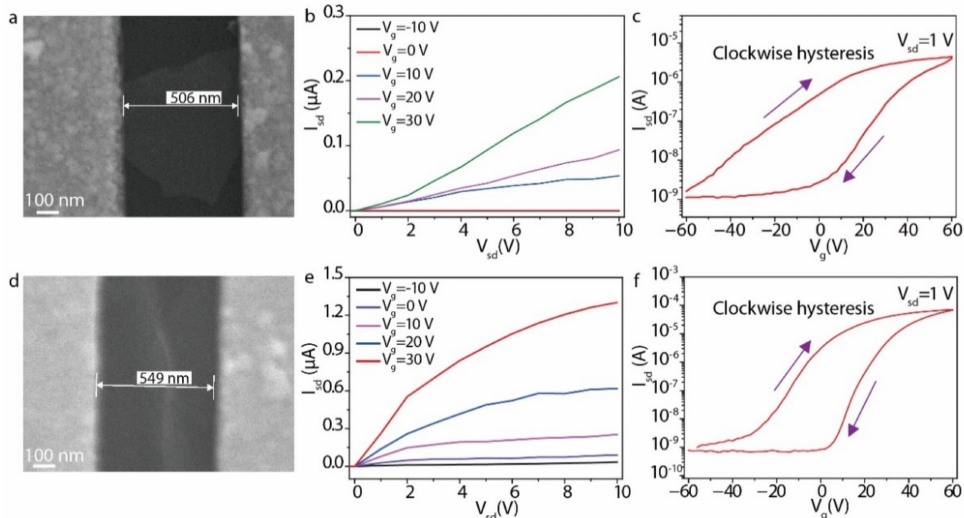
Figure 7. Transistor performance of In 2 Se 3 . ( a ) SEM image of the In 2 Se 3 single-flake FET with a single In 2 Se 3 nanosheet as the FET channel. ( b ) I sd – V sd output characteristics of the In 2 Se 3 single-flake FET. ( c ) I sd – V g transfer characteristics of the In 2 Se 3 single-flake FET. ( d ) SEM image of the In 2 Se 3 thin-film FET channel. ( e ) I sd – V sd output characteristics of the In 2 Se 3 thin-film FET. ( f ) I sd – V g transfer characteristics of the In 2 Se 3 thin-film FET.